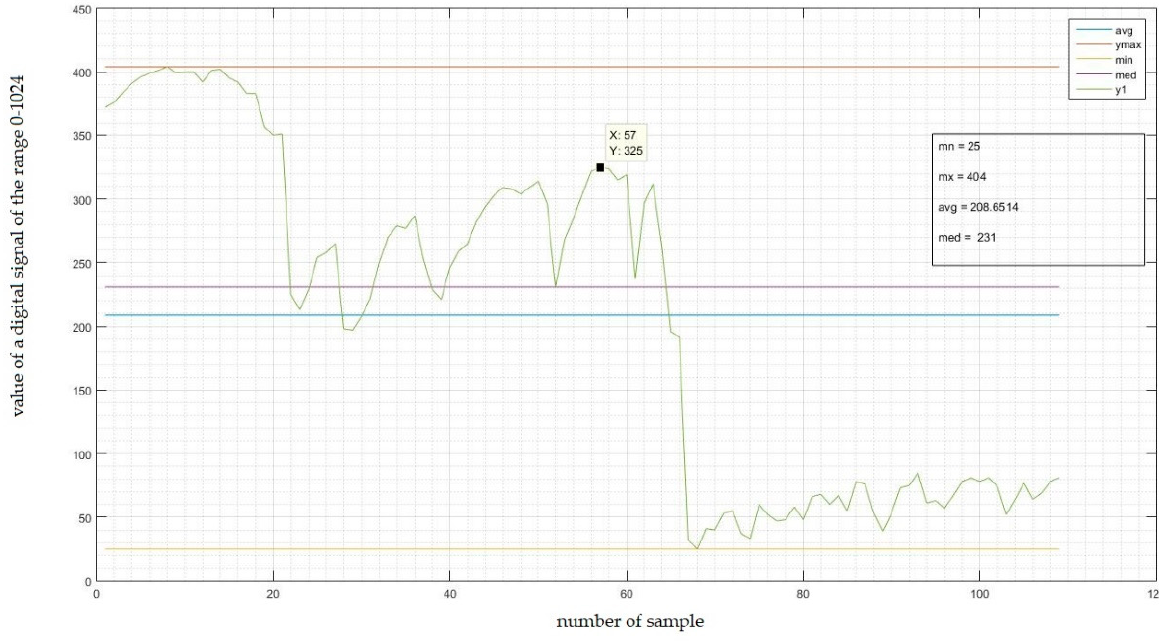
Figure A4. Data from the sensor on a straight forefinger.